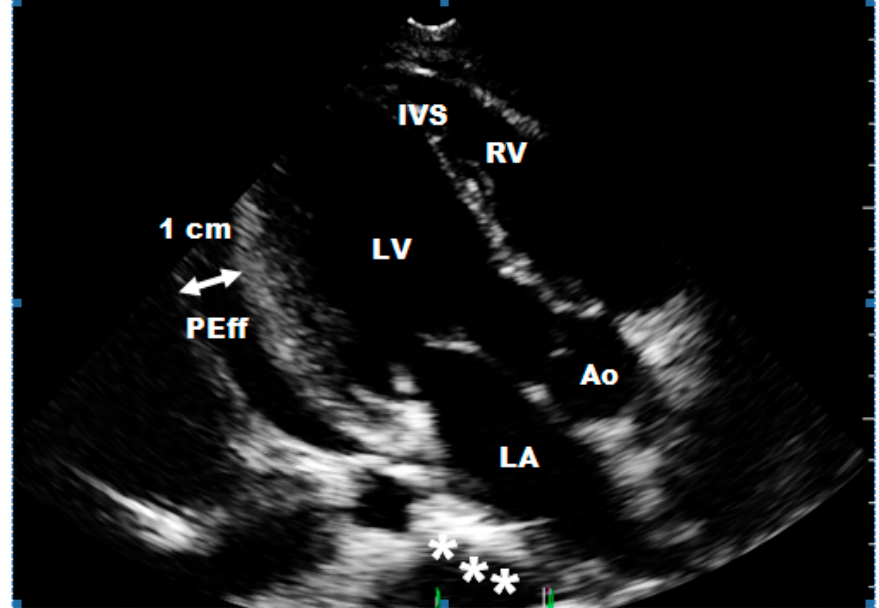
Figure 1. Two-dimensional echocardiography: parasternal long axis image obtained in a 16-year boy shows a huge hyperechoic mass (*) in the left atrium (LA) which was significantly hindering the flow of blood to the left ventricle through the mitral valve. RV—Right Ventricle; IVS—Interventricular Septum; LV— Left Ventricle; LA—Left Atrium; Ao—Aorta.